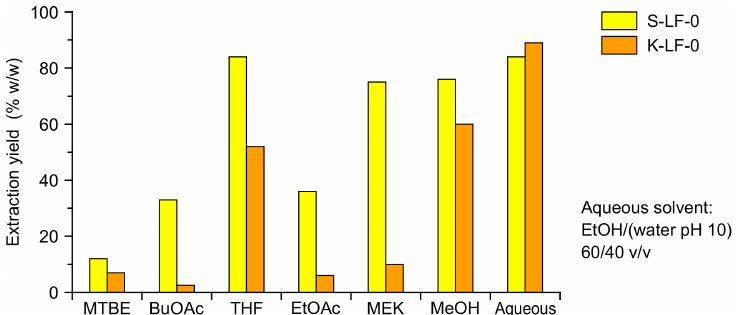
Figure 3. Extraction yields as the percent ( w / w ) of solubilized fraction vs. total fraction for S-LF-0 (yellow) and K-LF-0 (orange) for di ff erent organic solvents and for the (basic) aqueous